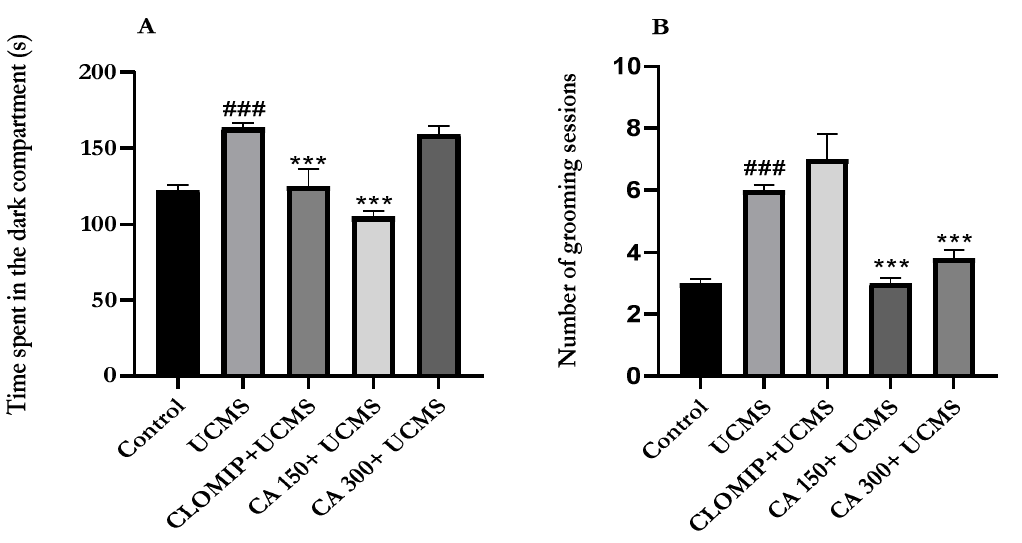
Figure 3. Effect of DCM/MeOH extract of C. adansonii on time in the LDBT (A) and number of groomings in OAT (B) after 30 days of treatment Each bar represents the mean ± MSE, UCMS: chronic mild unpredictable stress; CLOMIP + UCMS: positive control receiving clomipramine (20 mg/kg); CA + UCMS: animals receiving the DCM/MeOH mixture extract (v/v: 1/1) of C. adansonii at 150 and 300 mg/kg. ***p < 0.001 compared to UCMS group. ###p < 0.001 compared to the normal